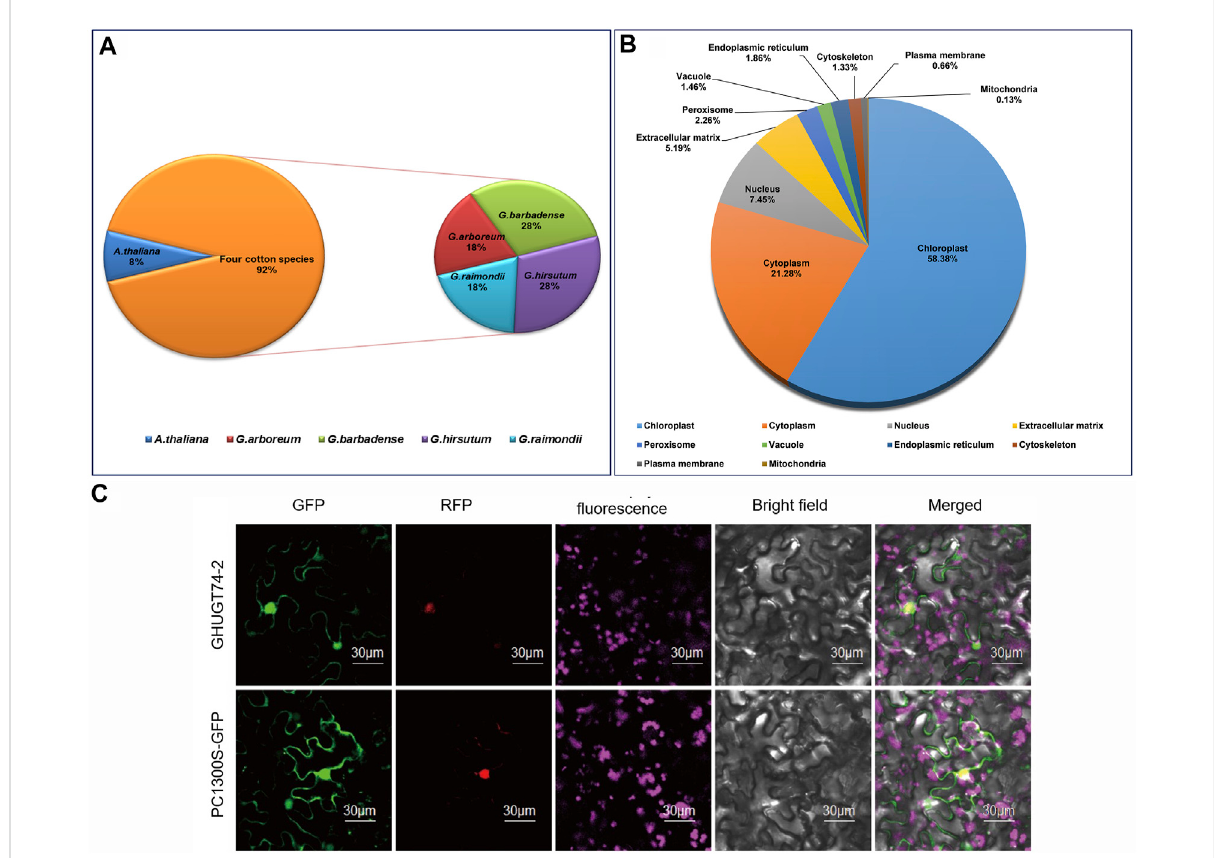
FIGURE 1 (A) Distribution of 818 UGTs from fi ve plant species. (B) Subcellular localization of 752 UGT proteins from four cotton species. (C) Subcellular localization of GHUGT74-2 proteins carried out in tobacco